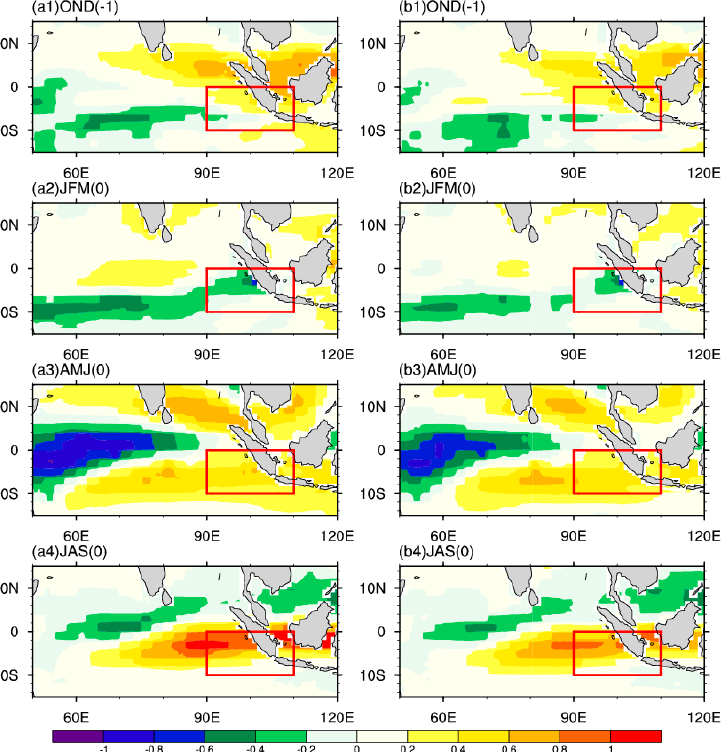
Figure 7. Seasonal variation in latent heat flux caused by ( a ) the type-1 and ( b ) the type-2 initial errors with the start month being October ( − 1). The inhibition of the loss of the latent heat flux is positive in the figures.